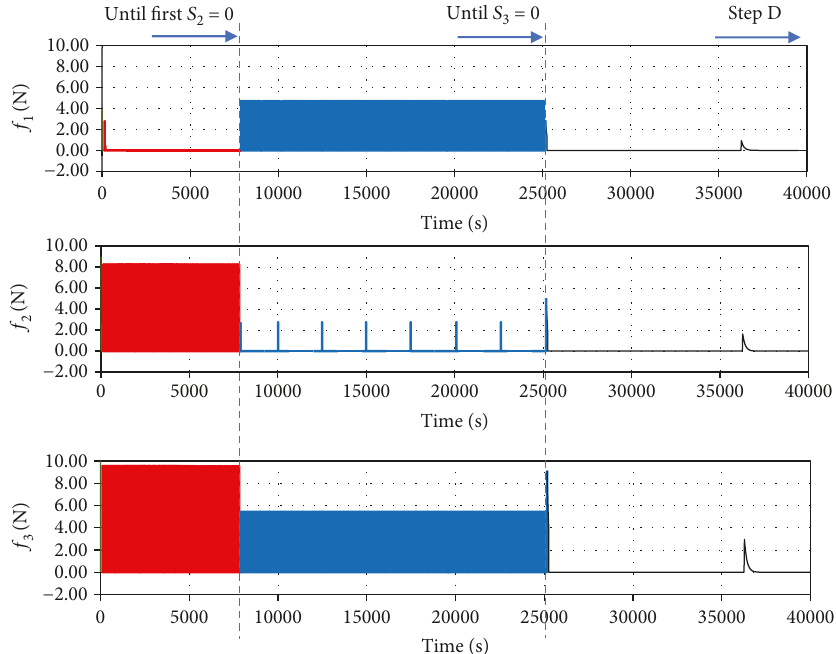
Figure 10: Time history of thruster forces in case 1. Thruster 1 generates f